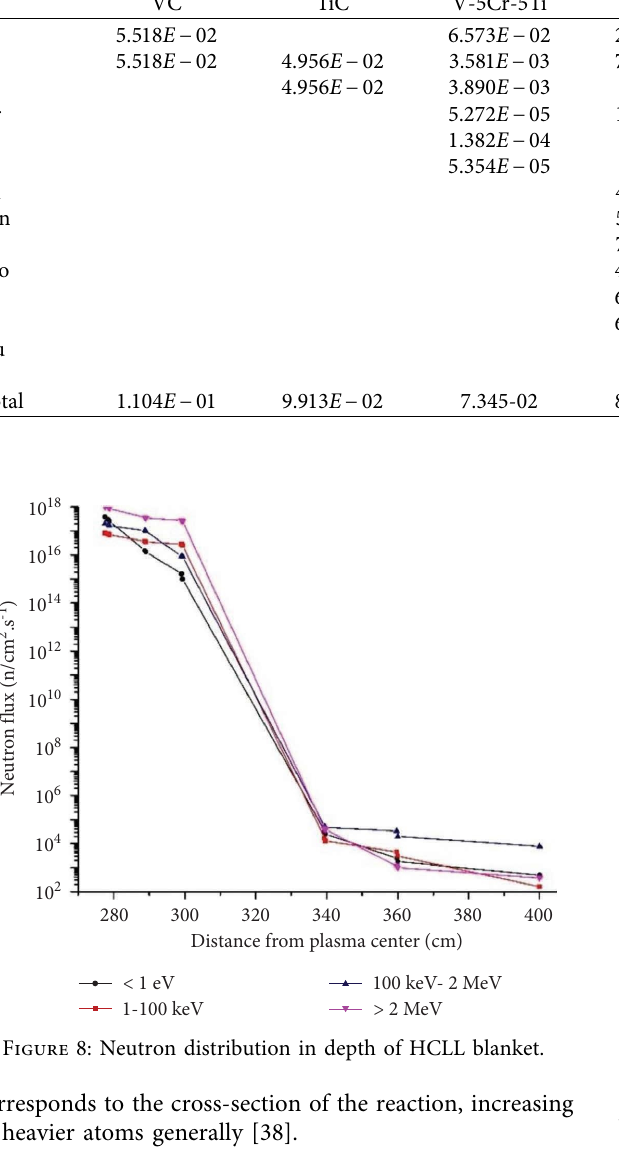
Table 3: Atomic densities of candidate materials used in the frst wall to increase the neutronic performances in blanket HCLL module. Nucleus